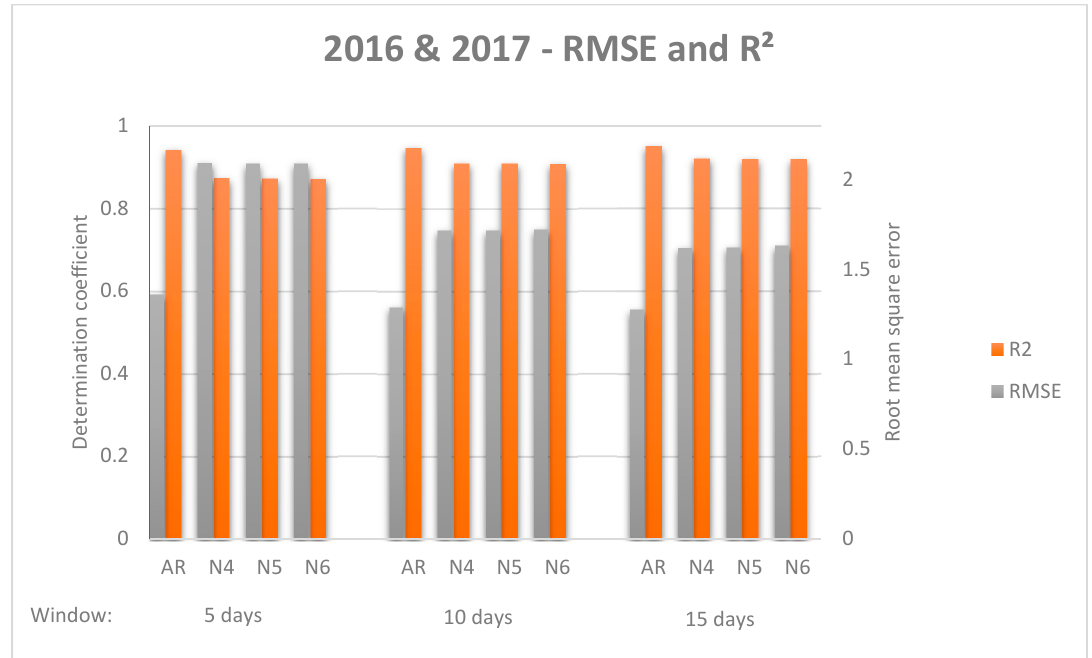
Figure 6. Comparison of forecasting models attending different windows for data 2016 & 2017. Root mean square error and coefficient of determination for each model and window are shown.